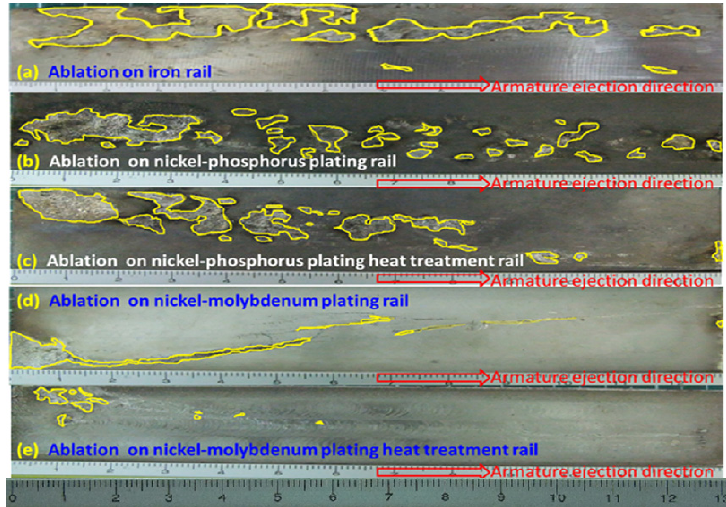
Figure 5. Surface ablation morphology of different rail. (unit: cm).